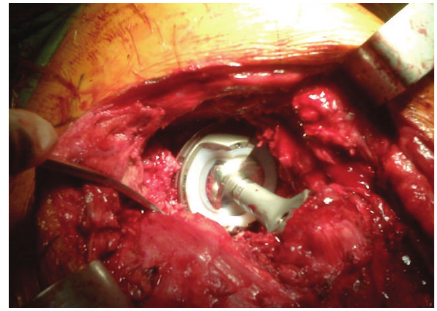
Figure 7: New exchanged constrained liner.